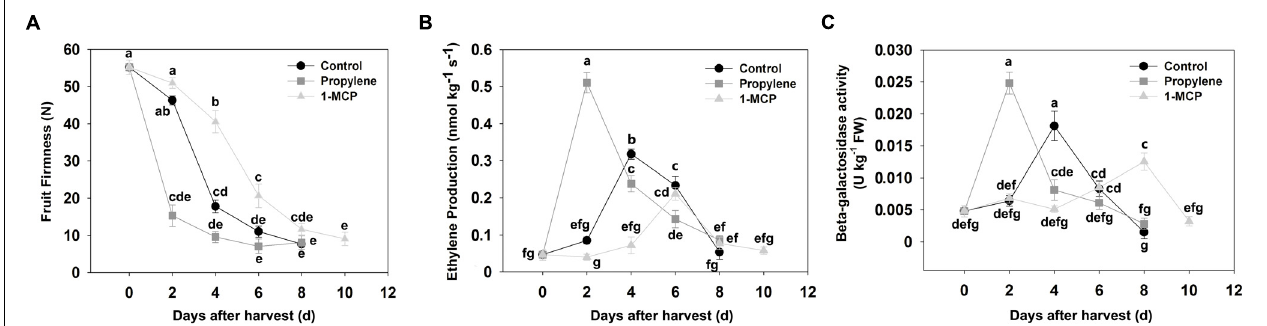
FIGURE 1 | Fruit firmness, ethylene production, and β -galactosidase activity in control, propylene-treated, and 1-MCP-treated ‘Qian Jian Bai’ peach fruit during storage. (A) Fruit firmness; (B) ethylene production; (C) β -gal activity. Each experiment was repeated three times. Data represent the mean ± SE ( n = 3). Significant differences ( p < 0.05) between means are indicated by different